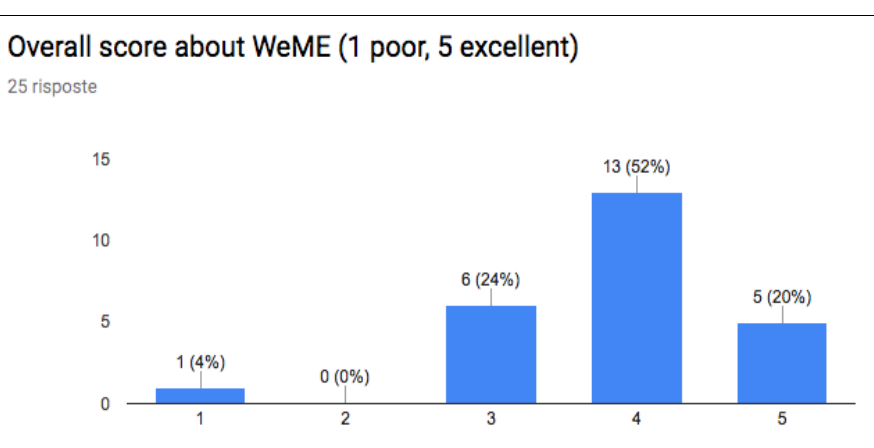
Figure 20. Overall opinion on the